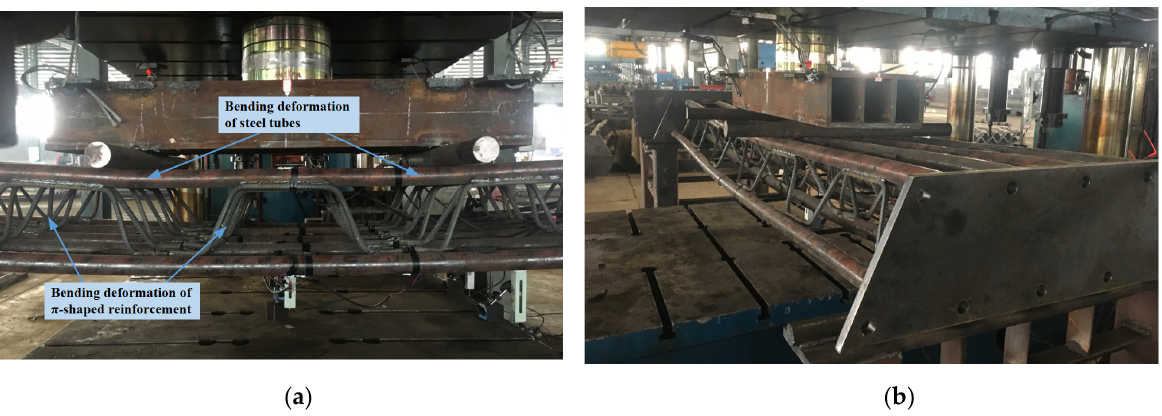
Figure 11. Failure mode of the end-plate joint component. ( a ) Elevation view and ( b ) axonometric drawing.